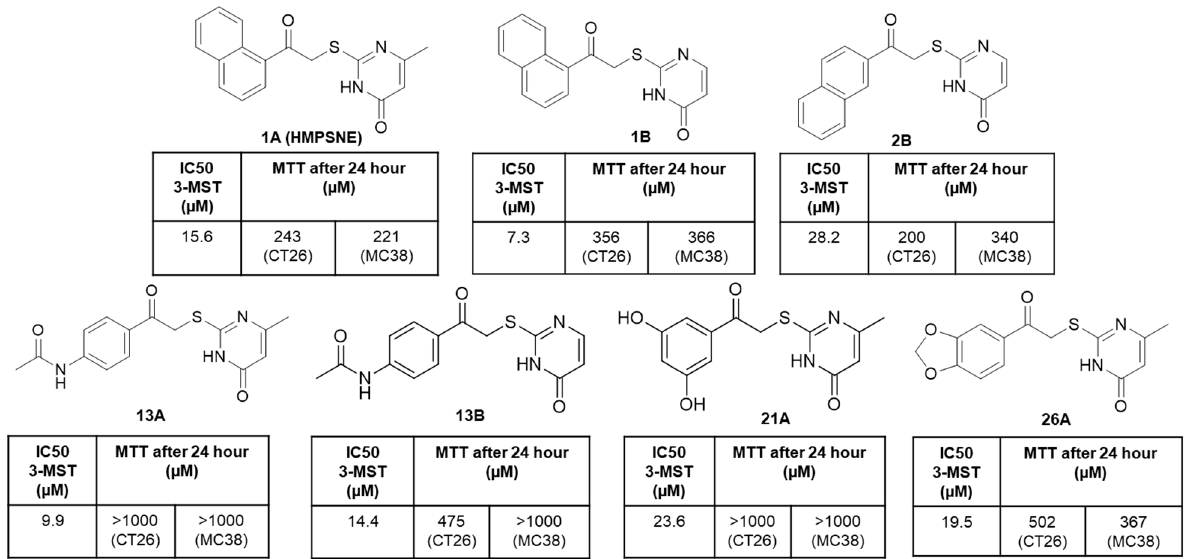
Figure 3. Recently developed 3-MST specific inhibitors and characterization for the anti-cancer activity. Compounds were subjected to IC50 determination in enzymatic assay with recombinant 3-MST (r3-MST) and in cell culture cytotoxicity assays using mouse CT26 and MC38 colon cancer cell lines. Compound 1B exhibited higher rate of inhibition against the enzyme in this series of compounds. Created using data from Bantzi et al.